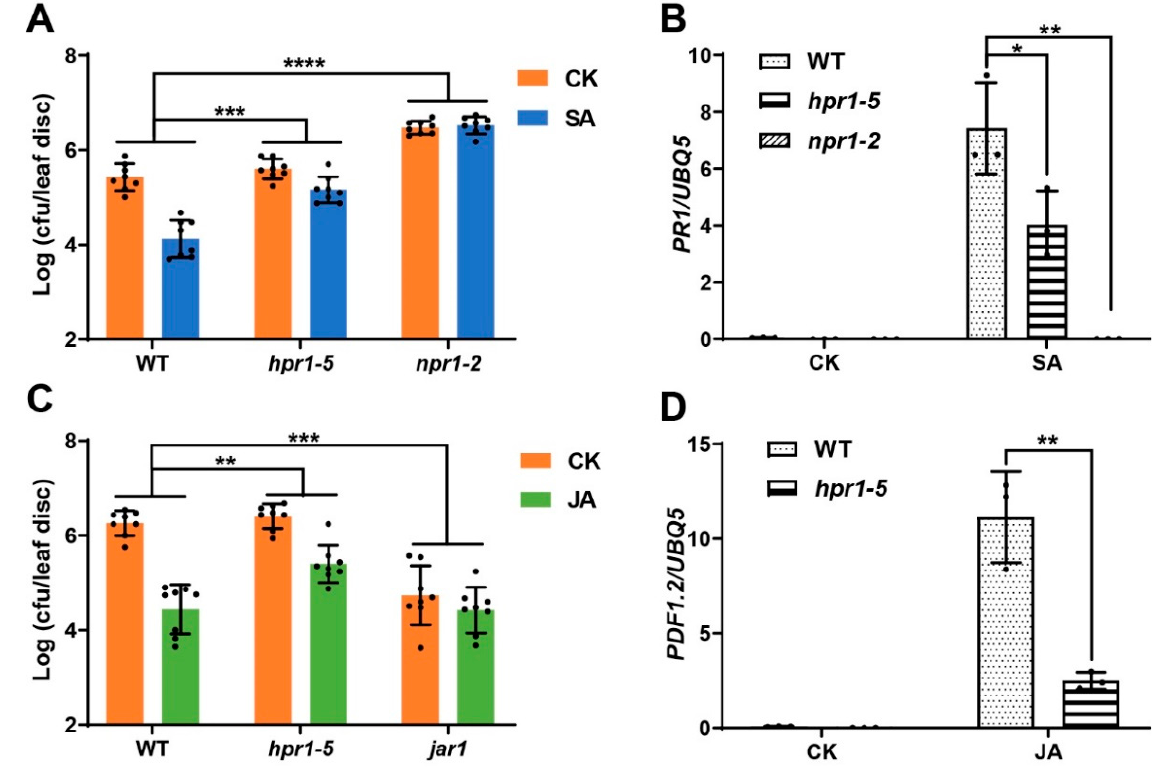
Figure 4. The phenotypes of SA and JA induced defenses in another eds8 mutant allele, hpr1-5 . ( A ) SA induced resistance to Psm ES4326 in WT, hpr1-5, and npr1 mutants. Significant difference was detected by two-way ANOVA. Data are shown as mean ± SD ( n = 8). ( B ) SA induced expression of PR1 in WT, hpr1-5, and npr1 mutants. Significant difference was detected using Student’s t -test. Data are shown as mean ± SD ( n = 3). ( C ) JA induced resistance to Psm ES4326 in WT, hpr1-5 and jar1 mutants. Significant difference was detected by two-way ANOVA. Data are shown as mean ± SD ( n = 8). ( D ) JA induced expression of PDF1.2 in WT and eds8 mutants. Significant difference was detected using Student’s t -test. Data are shown as mean ± SD ( n = 3). All these experiments were conducted as previously described and repeated three times with similar results. * p < 0.05; ** p < 0.01; *** p < 0.001; **** p < 0.0001.